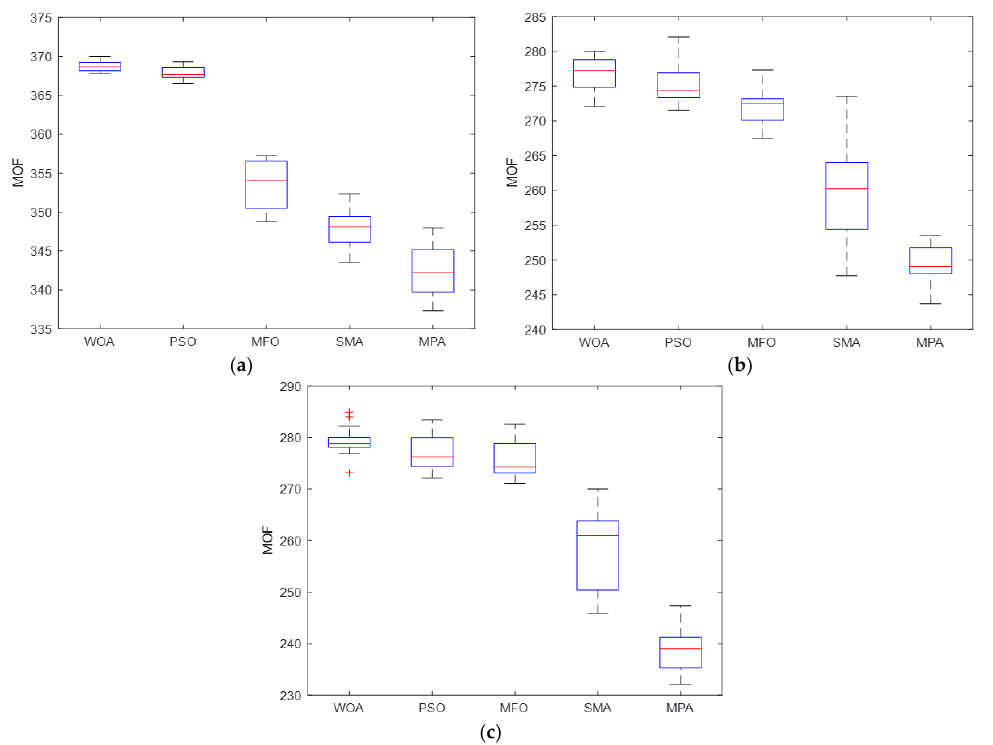
Figure 6. The MOF boxplot after applying the algorithms for the IEEE 33-bus: ( a ) PVDG case; ( b ) WTDG case; ( c ) Hybrid PVDG-WTDG case.